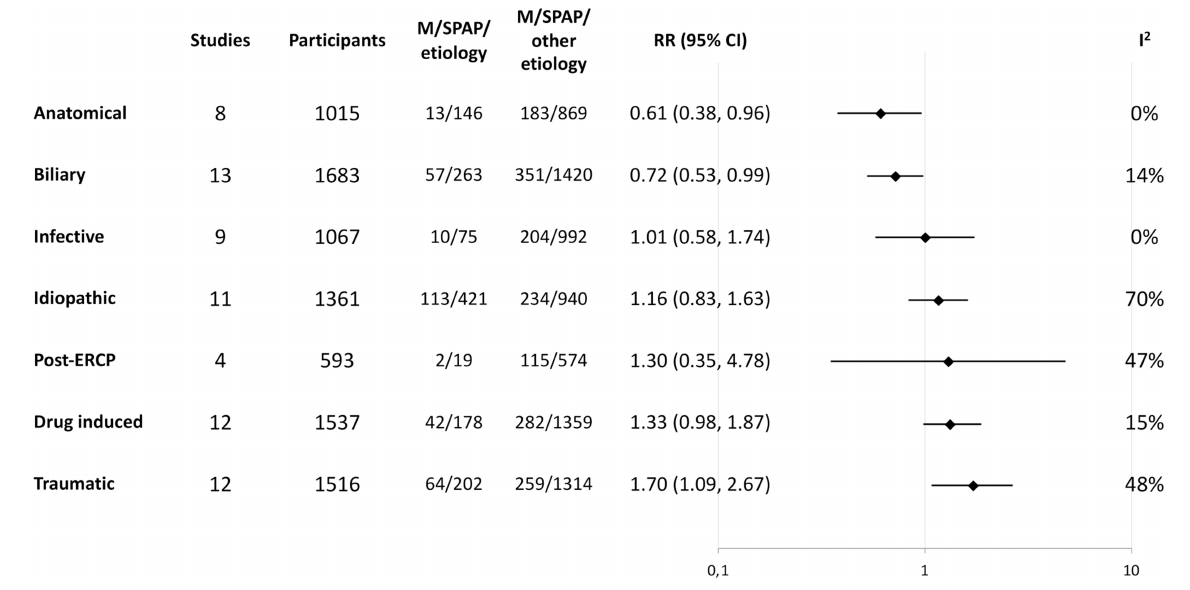
associated with M/SPAP (odds ratio: 3.23, 95% CI: 1.01–9.78, p = 0.038)